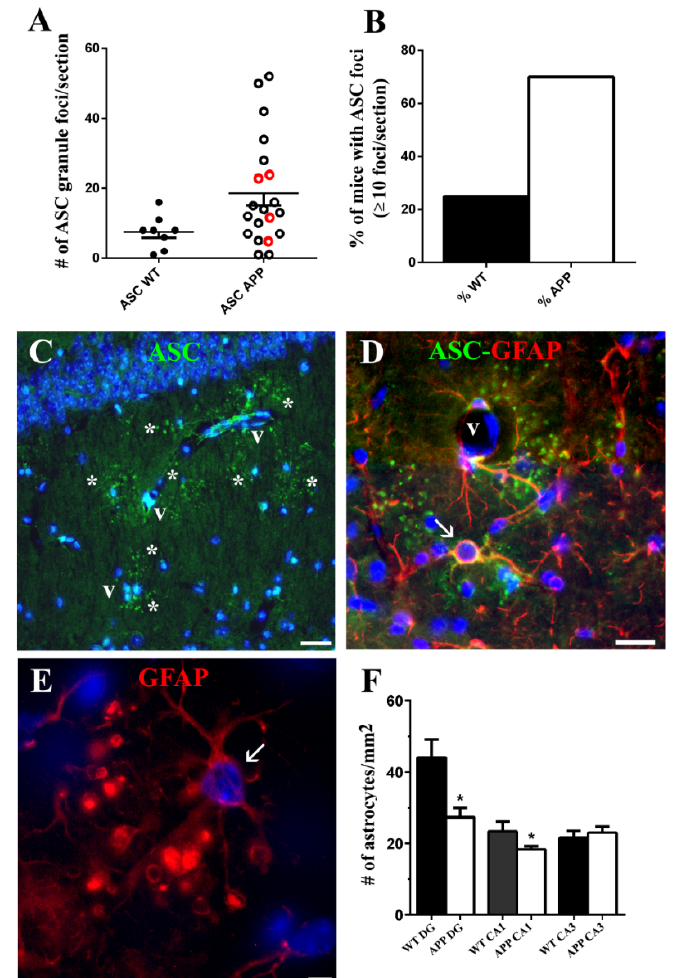
Figure 5. ASC foci development in HP is associated with blood vessels. Alteration of ASC granule- associated astrocytes might account for the decrease in astroglial density in APP radiatum. ( A ) shows a scatter plot of individual values corresponding to the total number of ASC granules foci per section in HP and DG in 8 WT and 20 APP (4 APP/P and 16 APP/D marked with red and black unfilled points, respectively). Note the tendency towards an increase in the number of ASC foci in APP. The graph in ( B ) shows that the percentage of mice developing ≥ 10 foci per coronal section in APP was around three times higher than in WT. ( C ) reveals that as many as 8 ASC foci (asterisks) are located around a blood vessel (v) segment, and ( D ) shows a perivascular astrocyte (arrow) containing ASC in its soma and process, surrounded by ASC granules. ( E ) shows an ASC-associated astrocyte (arrow) with prominent changesin the process terminal morphology. The graph in ( F ) indicates a significant decrease in the density of astrocytes in the strata radiatum of HP and hilus of DG of 3 APP versus 3 WT. In ( A , F ) the symbol # represents the number of ASC granule foci ( A ) and the number of astrocytes ( F ). Student’s test comparison between columns. * p ≤ 0,05 vs. WT. Scale bars represent 30 µ m in ( C ), 20 µ m in ( D ), and 5 µ m in ( E